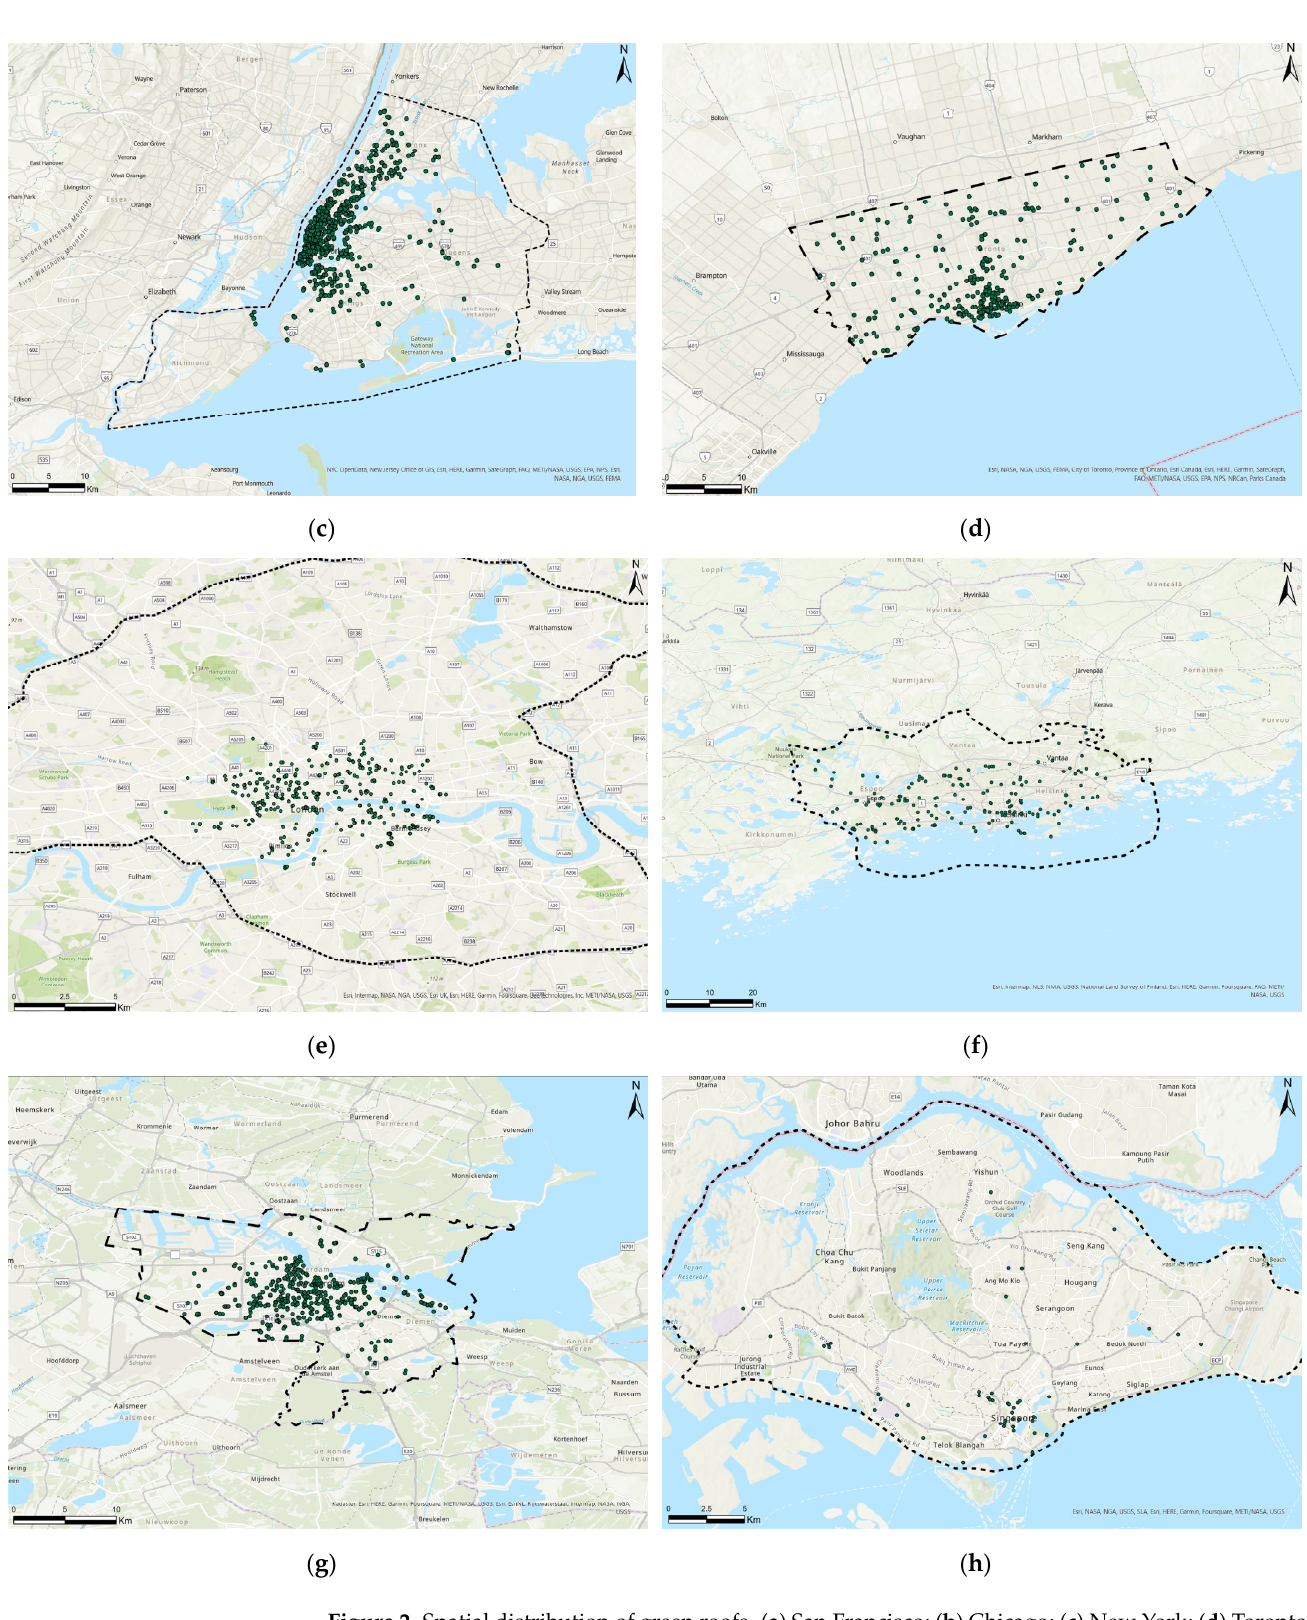
Figure 2. Spatial distribution of green roofs. ( a ) San Francisco; ( b ) Chicago; ( c ) New York; ( d ) Toronto; ( e ) London; ( f ) Helsinki; ( g ) Amsterdam; ( h ) Singapore.